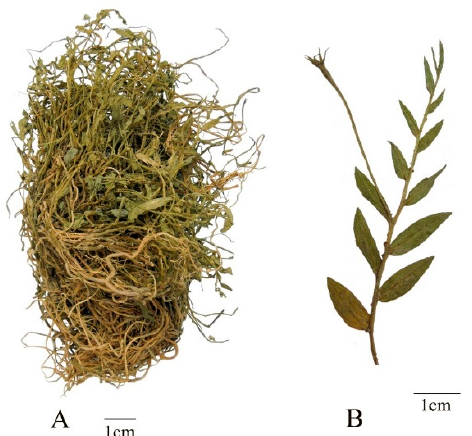
Figure 1. The representative photo of the collected herbal sample ( A ) and the herbarium specimen ( B ) of L. chinensis .